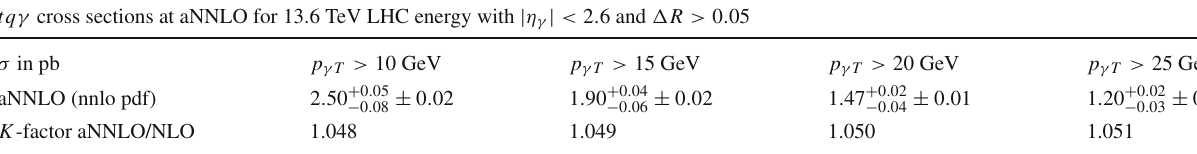
Table 9 The tq γ cross sections at aNNLO (in pb, with central value for μ = m t with scale and pdf uncertainties, and using cuts | η γ | < 1 . 5, 2.0, 2.6, and 3.0, as well as p γ T > 10 GeV and (cid:7) R > 0 . 05) in pp collisions with